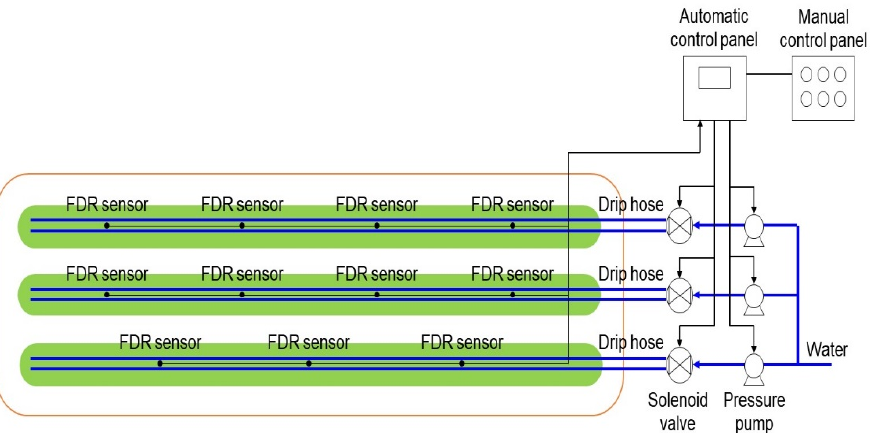
Figure 7. The schematic diagram of the experimental field with the automatic irrigation system.